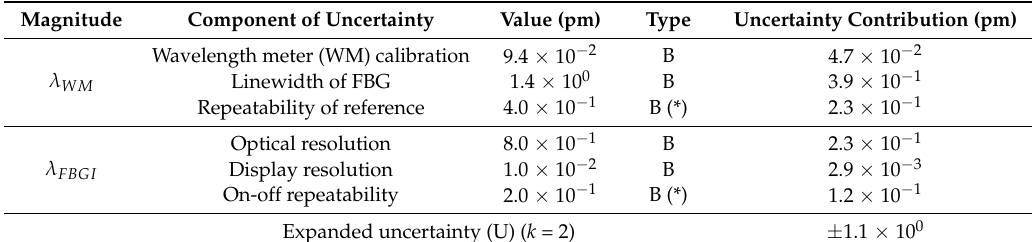
Table 3. Calculation of uncertainties of the first method experimental setup at λ WM ≈ 1530 nm. Magnitude